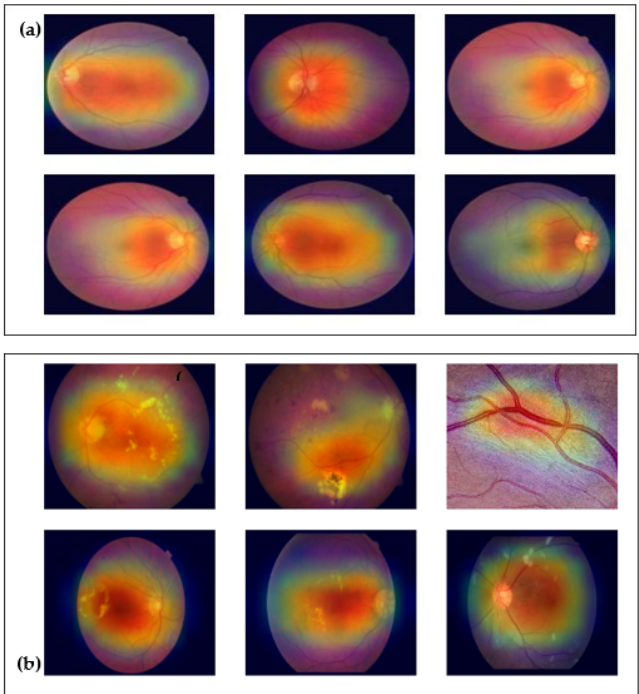
Figure 16. Feature visualization, where Mobile-HR was used to recognize hypertensive retinopathy using heat maps, which highlights the pathologic regions of HR: ( a ) normal heat maps and HR heat maps ( b ) based on the retinographic images. maps ( b ) based on the retinographic